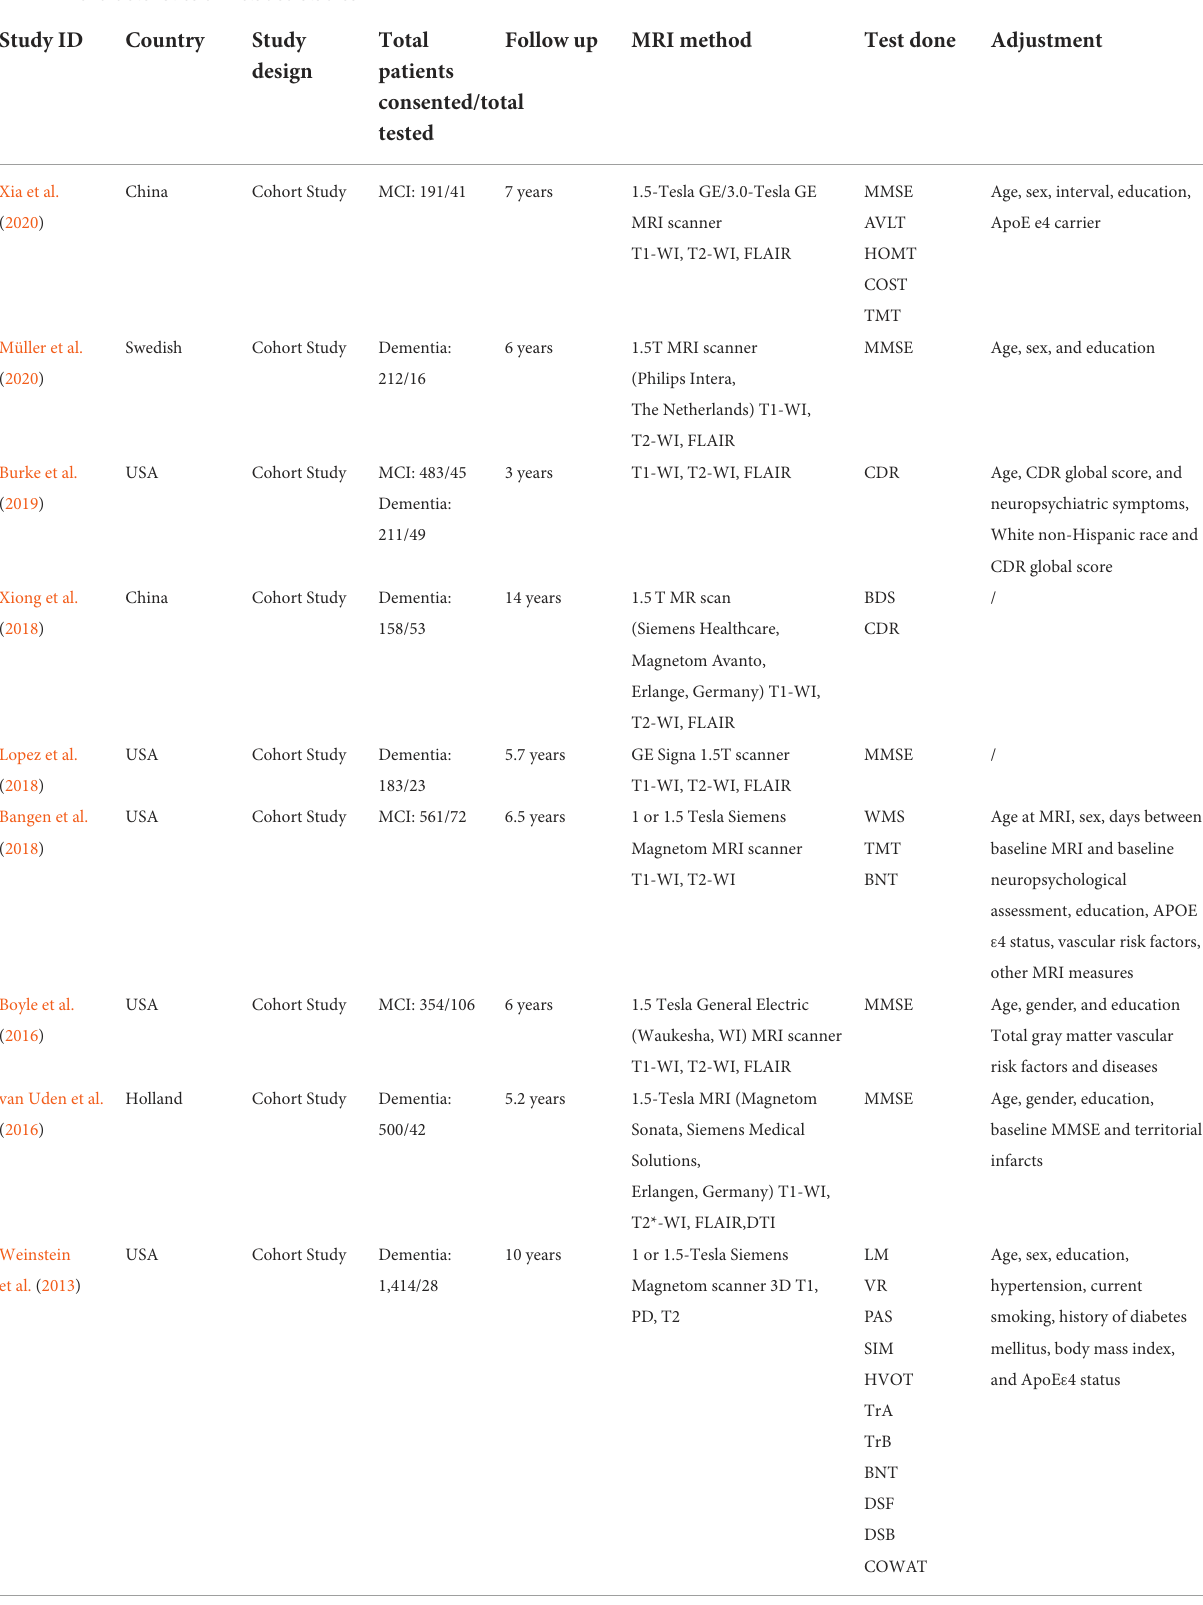
TABLE 2 Characteristics of included